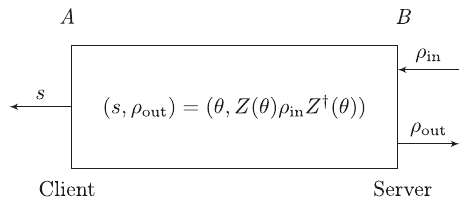
Fig. 1 Ideal Functionality of QEnclave: Remote State Rotation. Remote State Rotation (RSR) perform sarbitrary single qubit rotation with angel θ on income quantum state, outputs the angle at interface A and the post-rotation quantum state at interface B